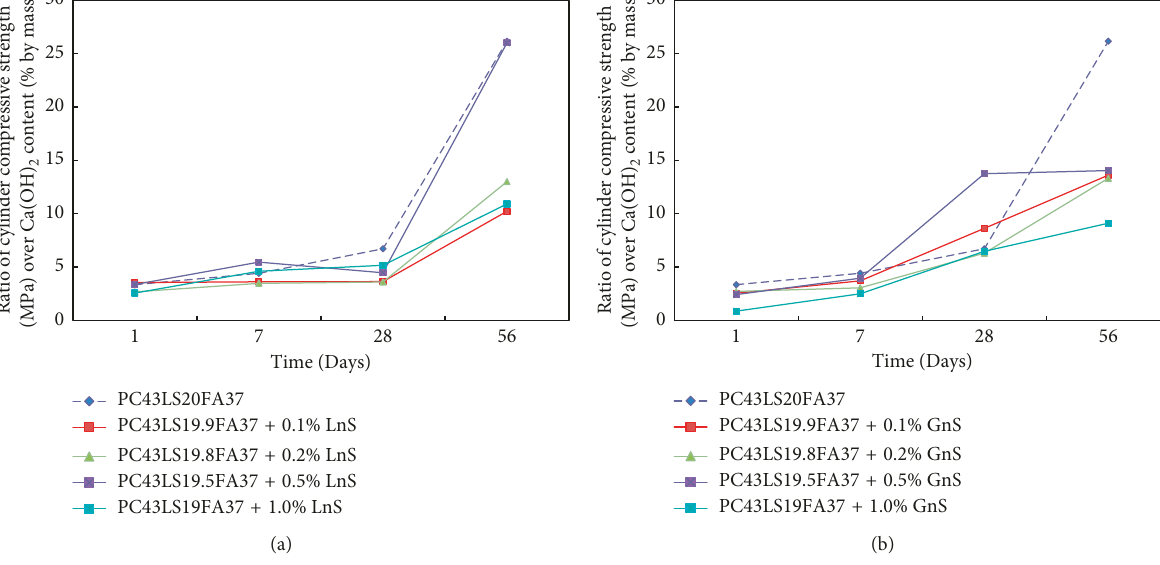
Figure 17: Relating microscale characteristics to macroscale performance of (a) LnS- and (b) GnS-modified nanocomposite binders based on